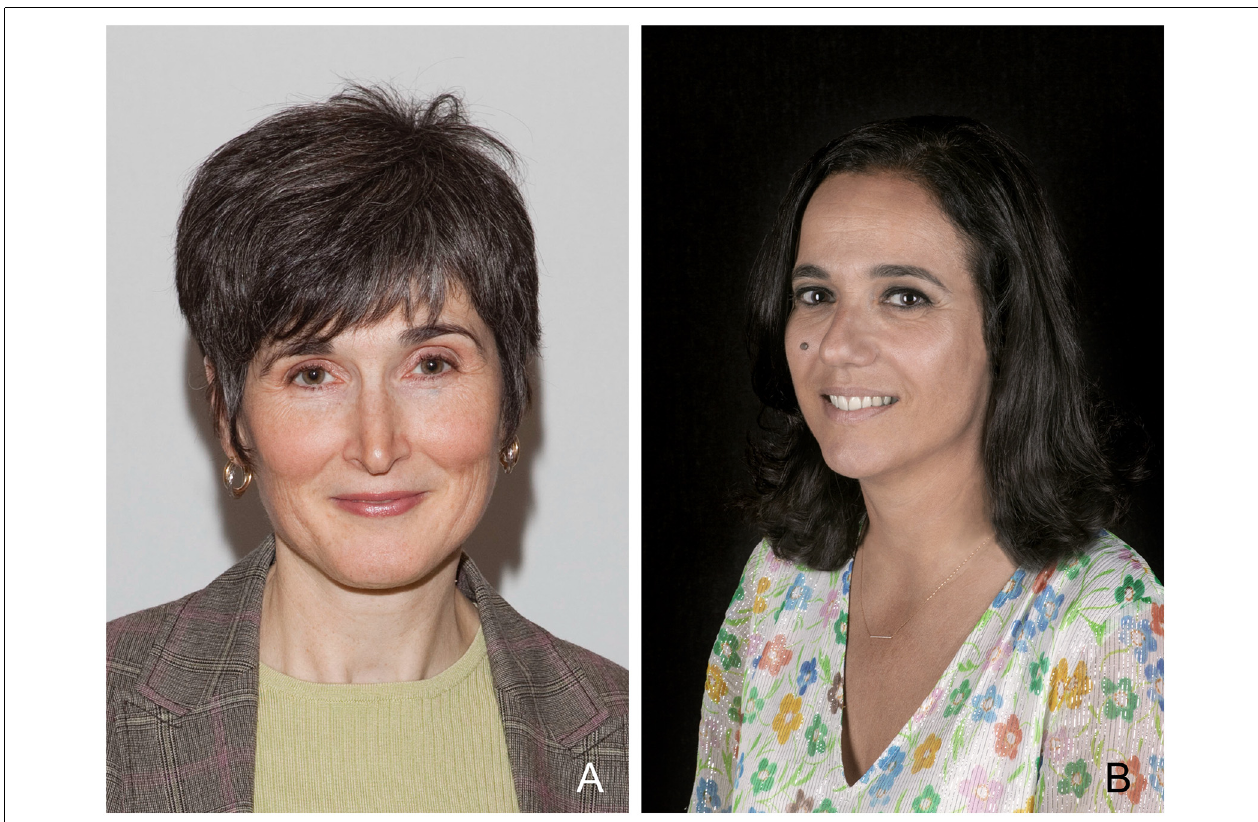
FIGURE 13 | (A) Zelma Kiss, provided by Zelma Kiss. (B) Jocelyn Bloch, provided by Jocelyn